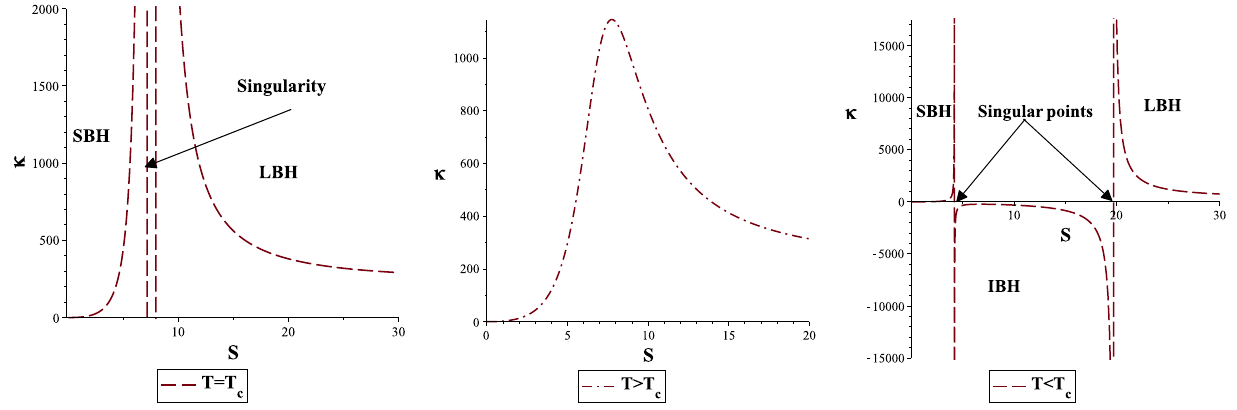
Fig. 13 κ versus S with a 2 = 1, e = 0 . 2 and g = 0 . 6. Left panel: T = T c , middle panel: T > T c and right panel: T < T